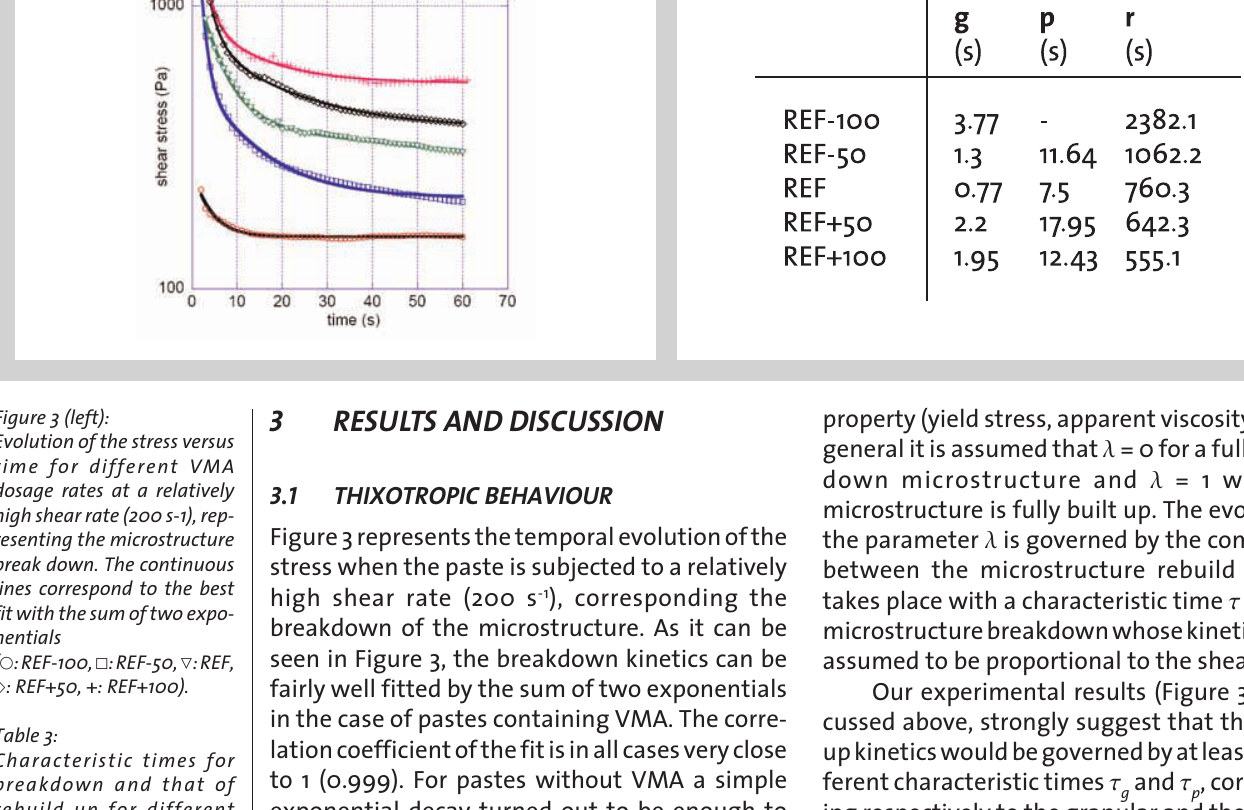
Table 3: Characteristic times for breakdown and that of rebuild up for different dosage rates of